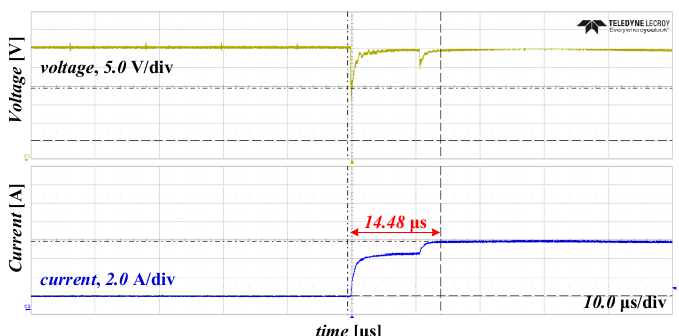
Figure 18. Experiment result for dynamic response: Step A → B (Case 1).